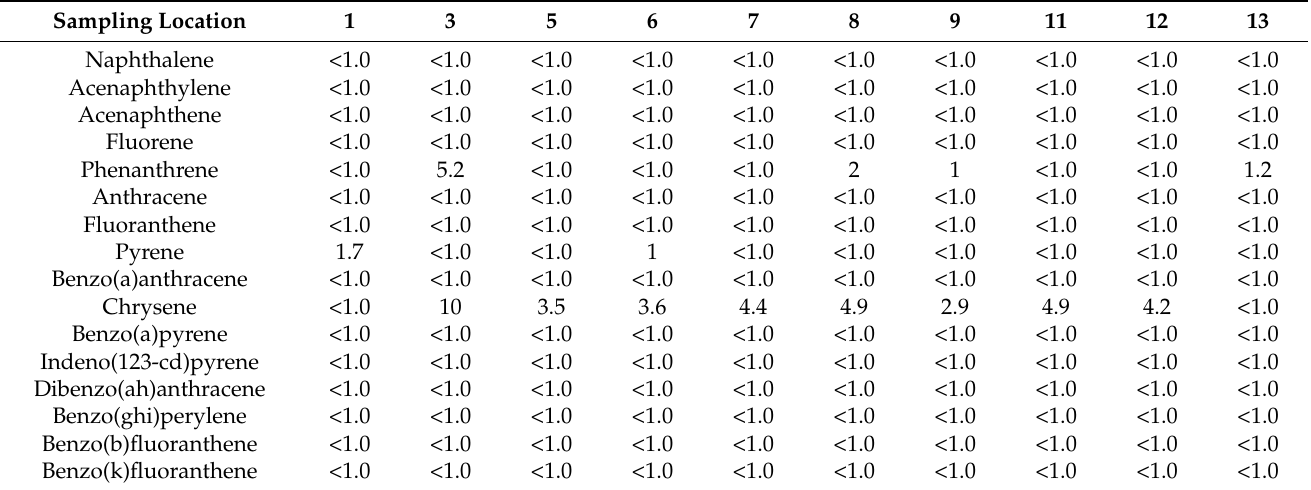
Table 3. Concentrations (mg/kg) of PAHs in the oily sludge samples collected from the oilfield waste pit.